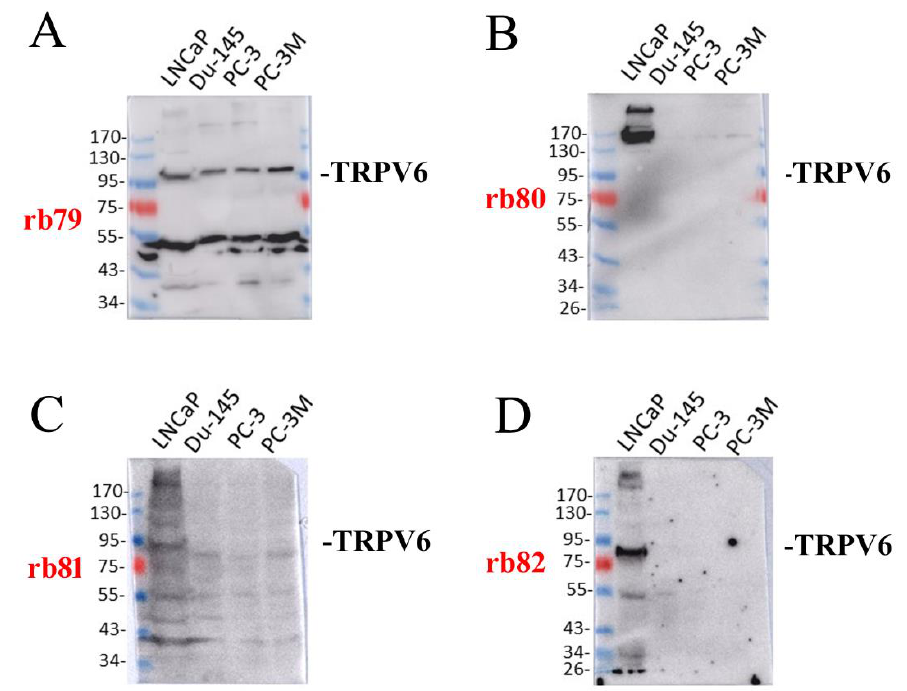
Figure 2. Immunoblotting studies of rabbit polyclonal antibodies rb79–rb82 in different cell lines. The immunoblotting of the total lysates of the LNCaP, DU-145, PC-3, and PC-3M cells in denaturing conditions revealed the presence of the rabbit polyclonal anti-TRPV6 antibodies rb79 ( A ), rb80 ( B ), rb81 ( C ), and rb82 ( D ).